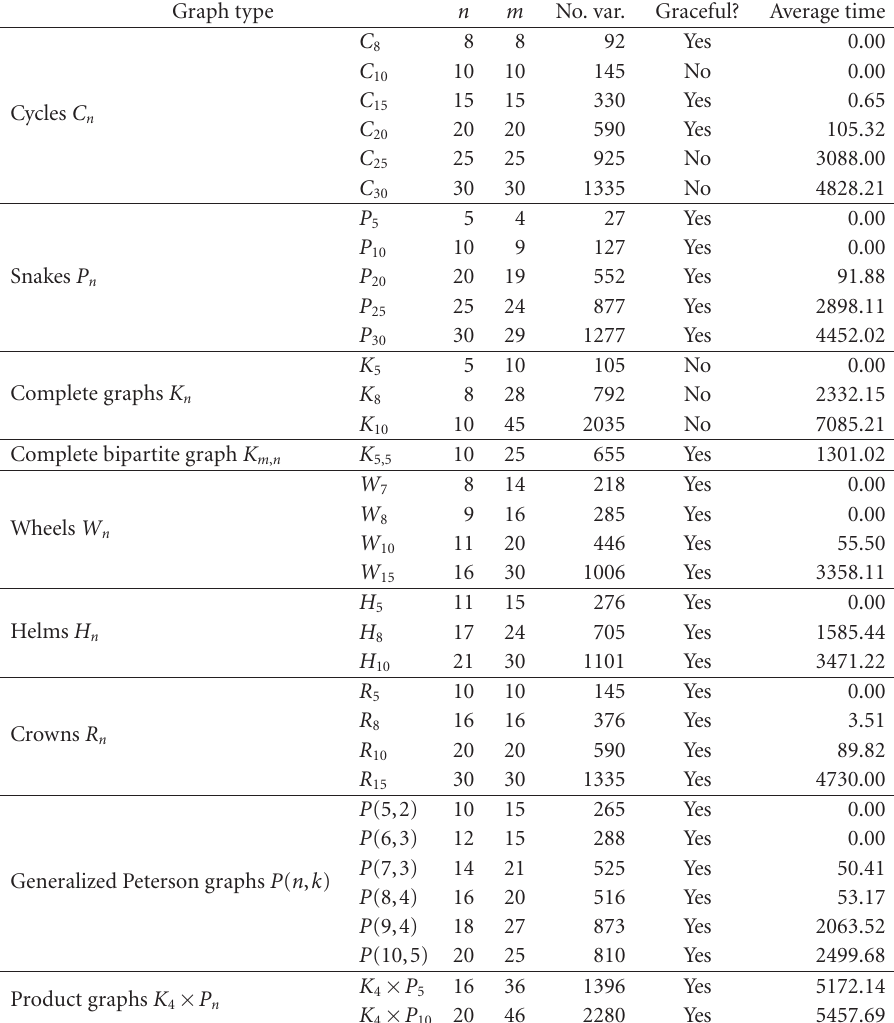
Table 4.2. The results of our algorithm for di ff erent classes of